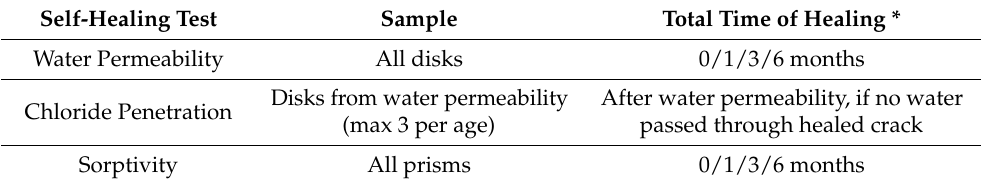
Figure 3. Indicative images of crack healing at time of cracking and at different healing periods for ( a ) REF and ( b ) ADD specimen. A gradual reduction of the crack width can be seen with increase of healing period. However, no precipitation of healing products was observed. (Scale 1 mm). Table 4. Testing program to evaluate